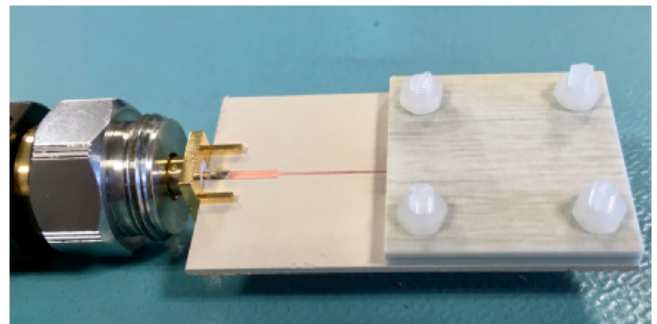
Figure 3. Detail of one of the sensors covered by the material under test (MUT). In order to avoid the presence of an air gap between the MUT sample and the sensing line, the sample was pressured against the sensing line by means of Teflon screws.